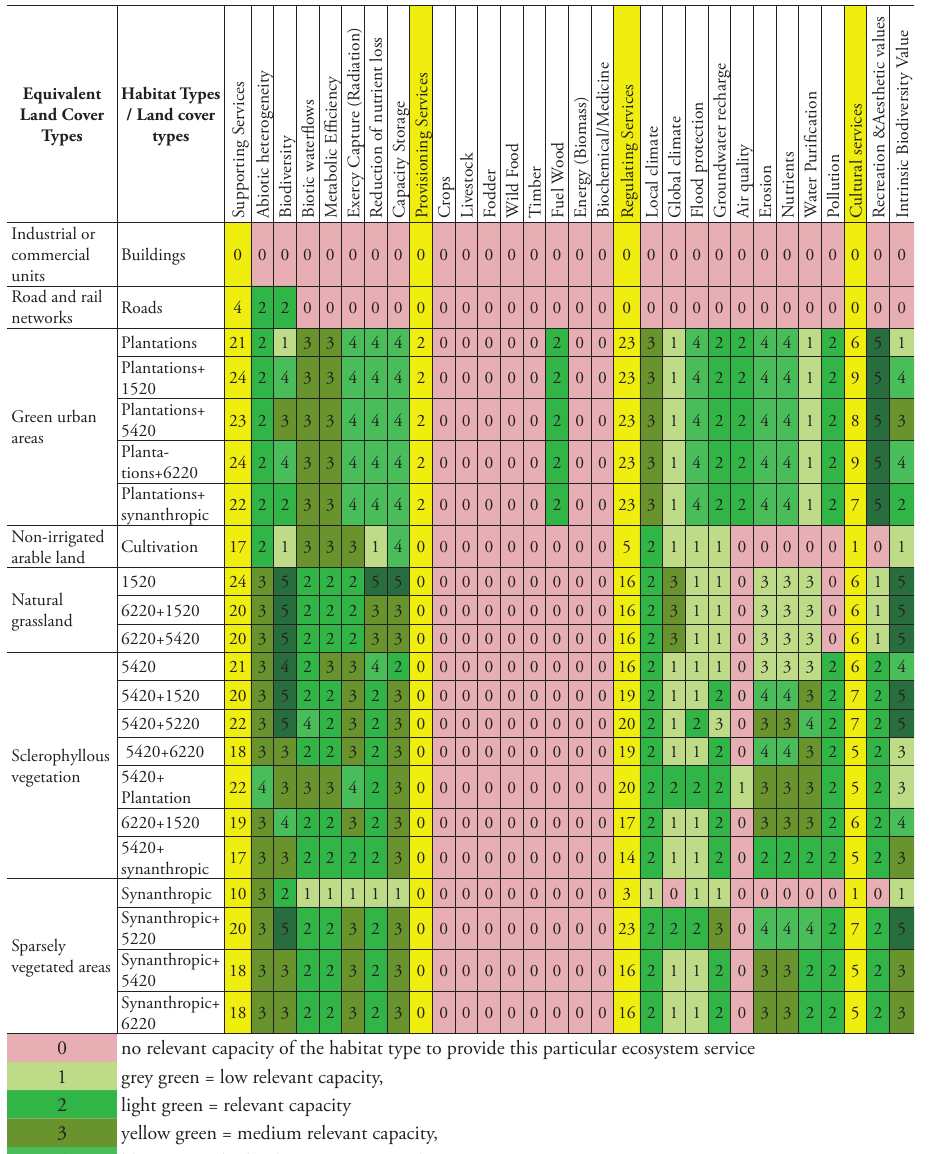
Matrix for the assessment of the different habitat types capacities to deliver selected ecosystem goods and ser- vices (adapted from Burkhard et al. 2009). The assessment scale ranges from 0–5 as described below. In the rows between the assessments (yellow colour), sums for the individual ecosystem services groups were